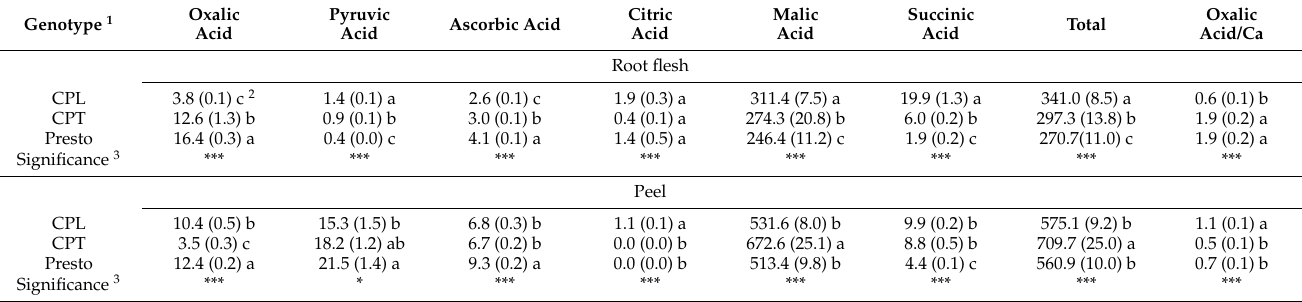
Table 5. Concentration of organic acids in the root flesh and peel of carrot genotypes (mg 100 g − 1